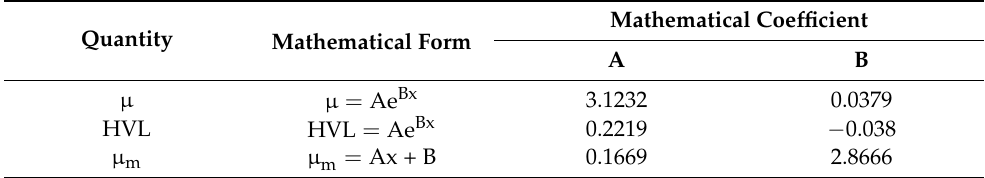
Table 7. Mathematical relationships between neutron-shielding parameters ( µ , HVL, and µ m ) and Sm 2 O 3 contents and their corresponding mathematical coefficients (A and B).